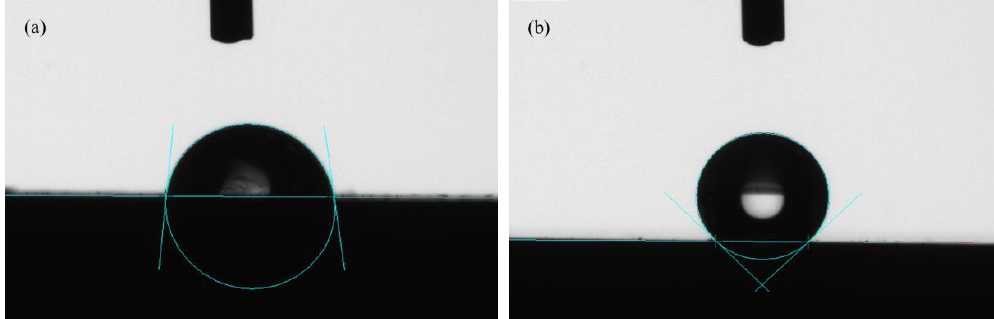
Figure 7. The contact angle of conversion-coated 5052 aluminum alloy: ( a ) before FAS-17 modification, ( b ) after FAS-17 modification.